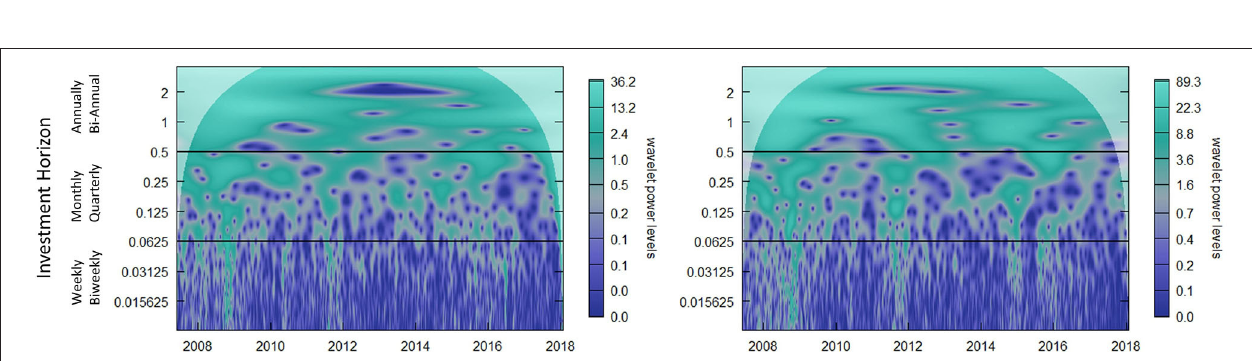
FIGURE 4 | The visualization process of the water-energy nexus has three distinct steps. (1) Identifying the investment horizons to investigate using the CWT. (2) Interpreting the dynamic interactions within the water-energy nexus using the WSC and WSD. And (3) analyzing any external factors impacting the dynamic behavior of the water-energy nexus.